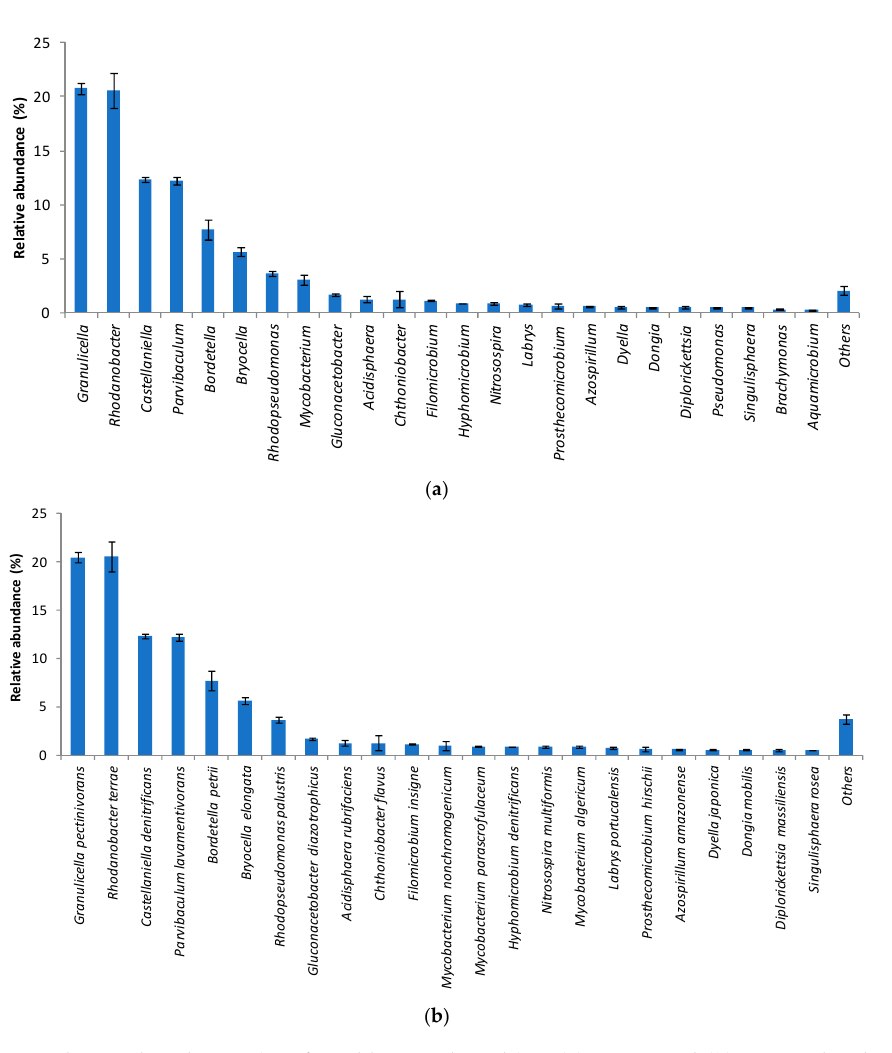
Figure 5. Relative abundances (% of total bacterial reads) at ( a ) genus and ( b ) species level of the major bacterial taxa in the immobilized cell biofilter treating diclofenac-based wastewater. Taxa with relative abundances below 0.25% are not reported. Only 0.25% of the sequences were not assigned to a taxonomically-described species. Genomes’ 16S RNA gene copies: Granulicella , 1; Rhodanobacter , 2; Castellaniella , 2; Parvibaculum lavamentivorans , 1; Bordetella petrii , 3; Bryocella ; not reported; Rhodopseudomonas palustris , 2; Gluconacetobacter diazotrophicus , 4; Acidisphaera , 1; Chthoniobacter flavus , 1; Filomicrobium , 1; Mycobacterium , 1; Hyphomicrobium denitrificans , 1; Nitrosospira multiformis , 1; Labrys , not reported; Prosthecomicrobium , 1; Azospirillum , 9; Dyella japonica , 2; Dongia , not reported; Diplorickettsia , not reported; Singulisphaera , 8.